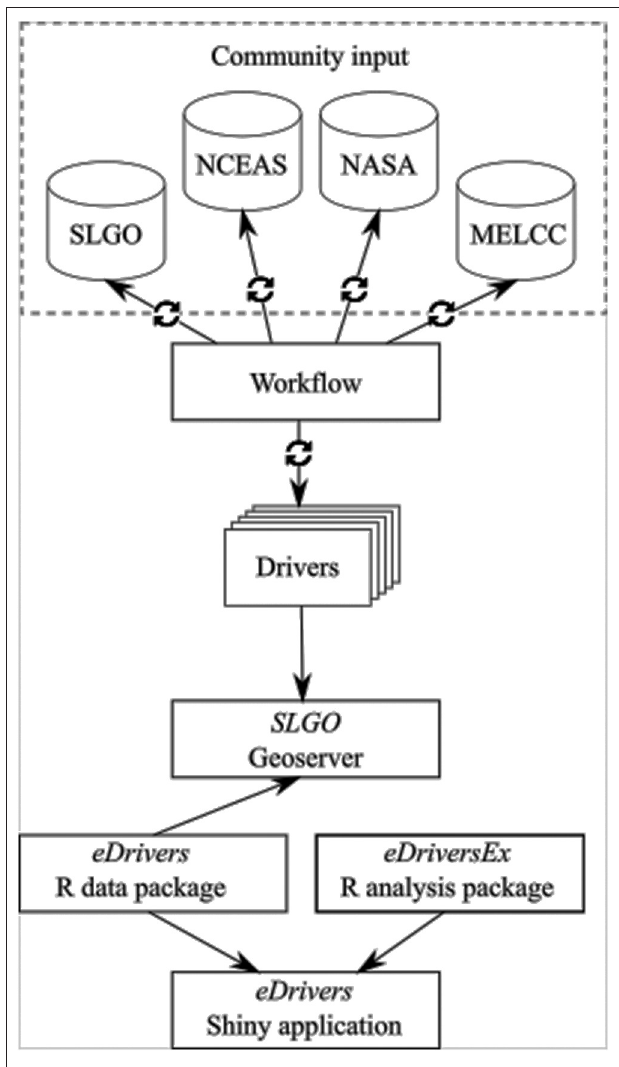
FIGURE 6 | Diagram of the platform structure. Community input in the form of raw data is accessed through the St. Lawrence Global Observatory (SLGO; https://ogsl.ca/en) repository—the platform host—or through open access repositories (e.g., NASA data). The raw data are then processed through a workflow hosted on the eDrivers GitHub organization (https://github.com/ eDrivers). Data processing may be as simple as data rescaling or make use of more complex methodologies. All data is then hosted on SLGO’s geoserver and accessible through their API. We developed a R package called eDrivers to access the driver layers through R and we are actively developing a second R package called eDriversEx that will include analytical tools to explore drivers data. Finally, we have developed a Shiny application, eDrivers app, that allows users to explore drivers data interactively (https://david-beauchesne. shinyapps.io/eDriversApp/). All R components of the project are hosted and available on the eDrivers GitHub organization. Iterative and adaptive processes are identified by circular